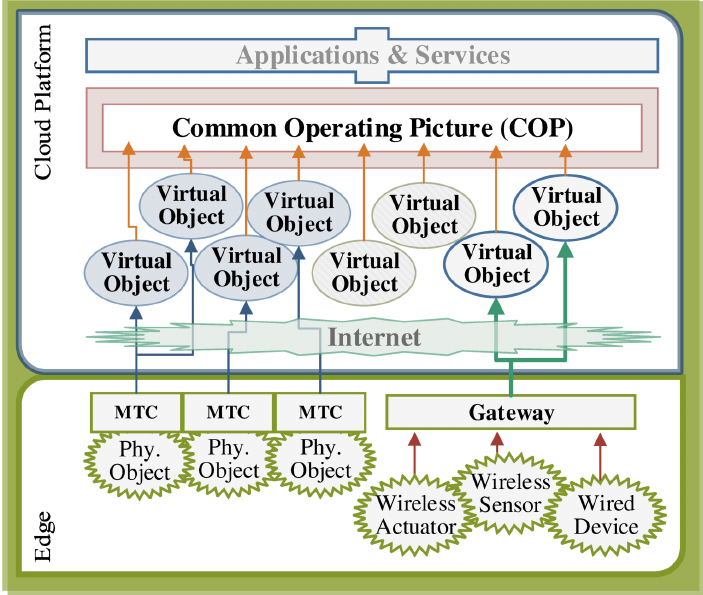
Figure 3. An Internet of Things platform with physical objects deployed at the edge. Some objects are connected to the Internet using machine-type communication (MTC) technologies whereas some are connected over a gateway. In either case, they are represented as virtual objects in the common operation picture, which is used by application and